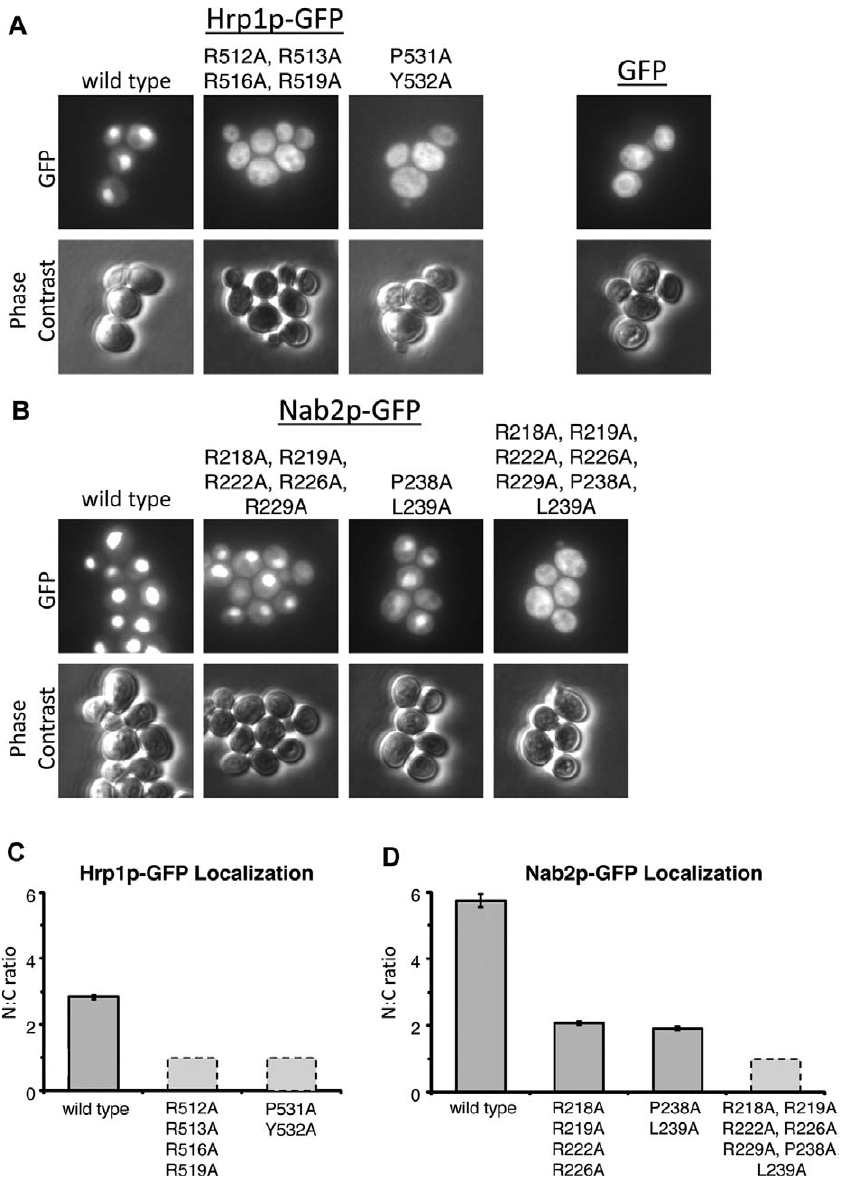
Figure 6. Hrp1p and Nab2p Mutants Are Mislocalized In Vivo (A) S. cerevisiae cells expressing either wild-type or mutant full-length Hrp1p–GFP fusion proteins were analyzed by fluorescence microscopy and phase contrast. GFP is displayed in the same fluorescence scale in each panel. (B) Cells expressing either wild-type or mutant full-length Nab2p–GFP fusion proteins were analyzed as in (A). (C and D) Mean pixel values were used to determine the nuclear/cytoplasmic (N/C) ratio of fluorescence intensity for either (C) Hrp1p–GFP or (D) Nab2p–GFP fusion proteins ( 6 standard error of the mean). Dashed lines indicate an estimated N/C ratio of 1:1 due to the diffuse nuclear and cytoplasmic localization of the fusion